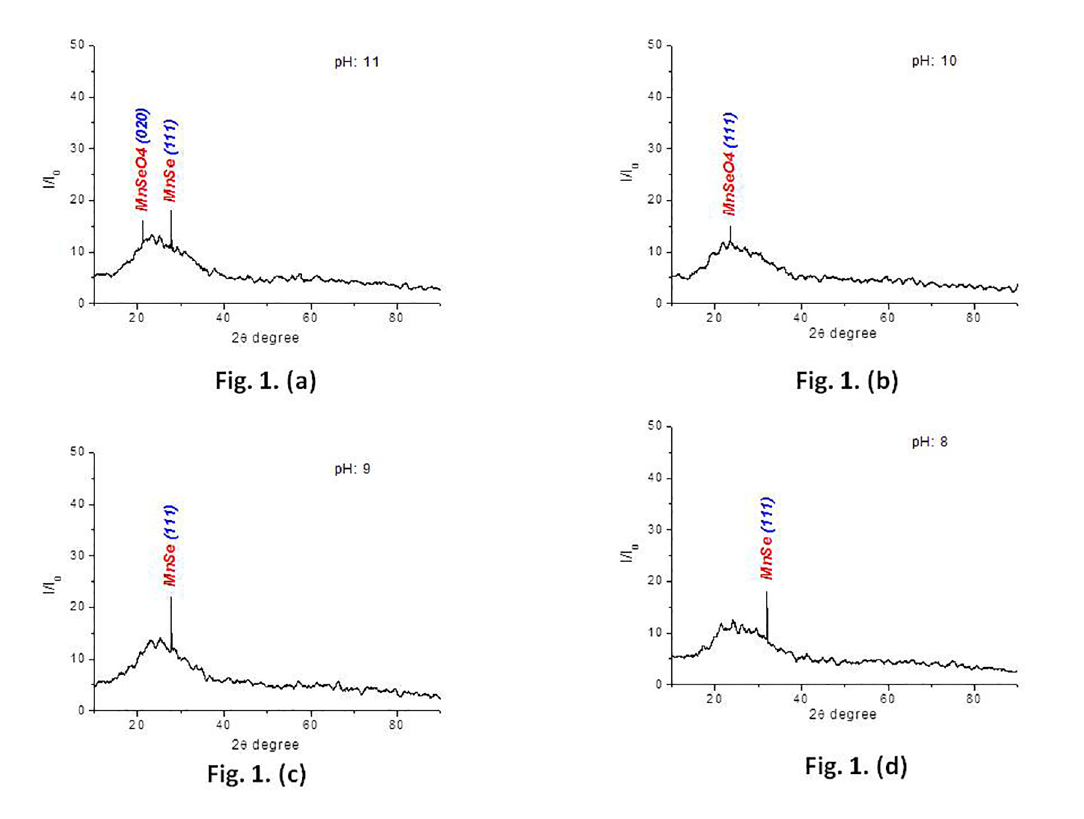
Figure 1. X-ray patterns of MnSe films deposited in a bath solution at: (a) pH : 11, (b) pH : 10, (c) pH : 9 and (d) pH : 8. Table 1. XRD data of ASTM values versus films pH